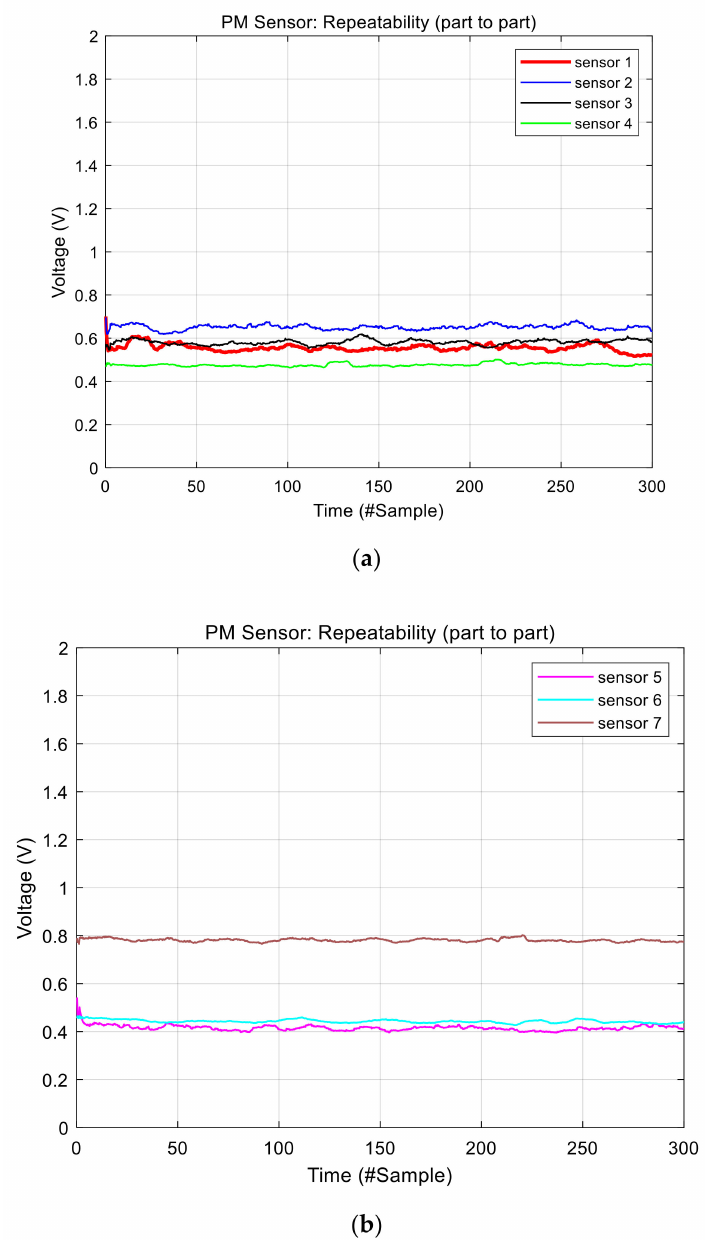
Figure 6. Result of the noise reduction: ( a ) data collected from sensor 1 to 4 and ( b ) data collected from sensor 5 to